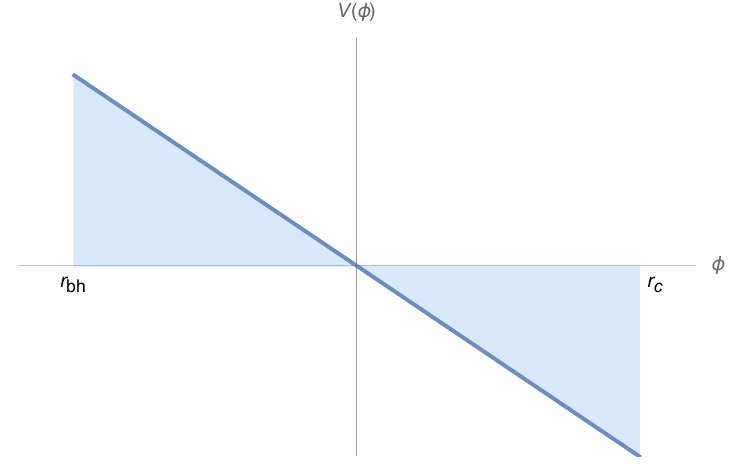
Figure 2 . The dilaton potential V ( φ ) = − 2 φ for the black hole in de Sitter. The solution caps off at the two horizons which have been indictated here as r bh and r c